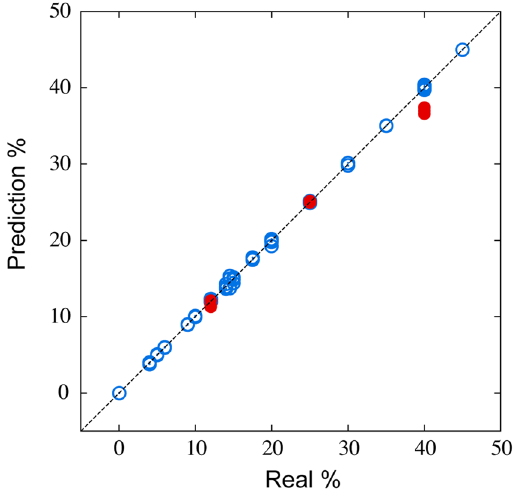
Figure 10. Parity plot of predicted alcohol content versus real alcohol content under an ambient condition when the parameter 3 of Phenyl-STNPs, the parameter 4 of polysulfone, and the parameters 1 and 3 of polycaprolactone were used. The blue points represent the known liquors which are used to train the ML model. The red points are the unknown liquors: red wine (12%), imo-shochu (25%), and whisky (40%).